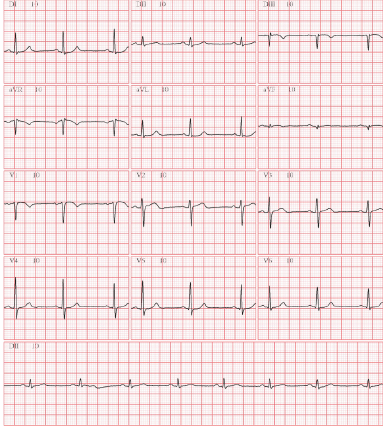
Figure 4: Predischarge